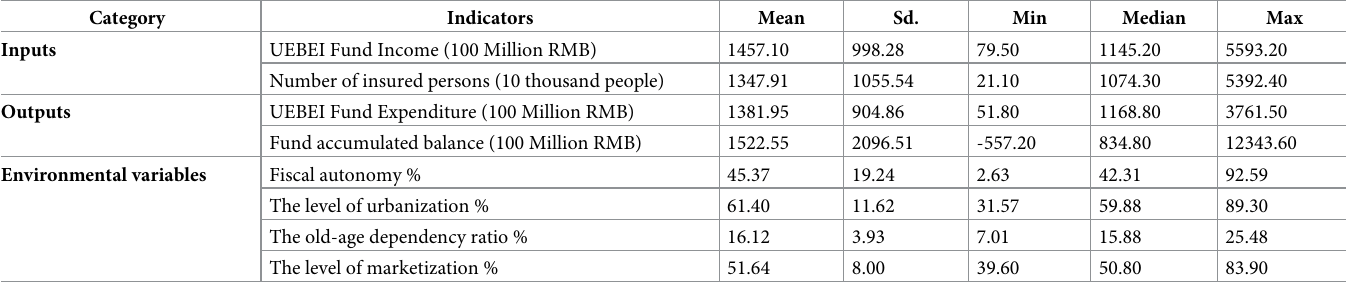
Table 1. Descriptive statistical analysis of input, output and environmental